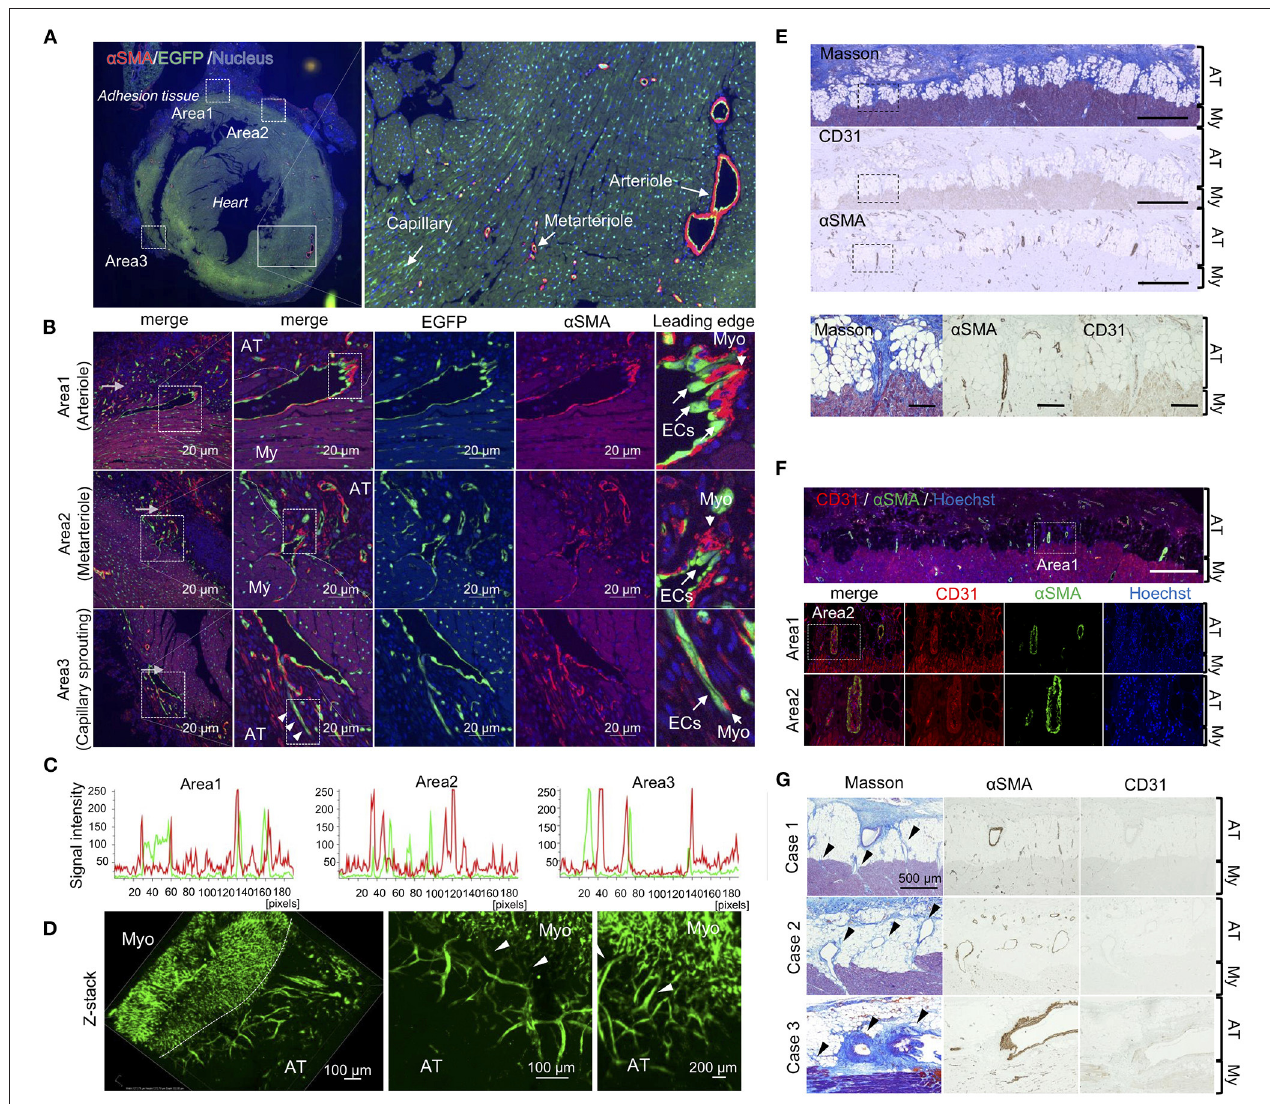
FIGURE 3 | Unique angiogenic sprouting from heart in mice and humans. (A) Left panel shows immunofluorescence of whole heart stained using anti- α SMA (red) and EGFP (green) antibodies. Nuclei were stained with Hoechst stain (blue). The right panel shows a magnified view of the quiescent area surrounded by solid lines in the left panel. (B) Magnified views of areas 1–3 in the left of (A) . The rightmost images indicate enlarged views of areas surrounded by broken lines in the second panel from the left. Arrowheads indicate sprouting vessels from the arteriole. Bar = 20 µ m. (C) Profiles of fluorescence signal intensities of α SMA ( red ) and EGFP ( green ) from areas 1–3 of the leftmost images in (B) . (D) Z-stacked images of heart tissue with adhesions in endothelial cell-specific EGFP-labeled mice. Heart tissue was excised and subsequently embedded into the type-I collagen gel, followed by obtaining z-stack three-dimensional images using A1 confocal microscopy. Arrowheads indicate vascular connective points between the heart and adhesions. My, myocardium; AT, adhesion tissue. (E) The upper panels show Masson’s trichome staining and immunohistochemical (IHC) results for α SMA and CD31 in the human heart (Scale bar = 1mm). The lower panels show magnified images of areas surrounded by broken lines in the upper panels (Scale bar = 200 µ m). (F) Immunofluorescence co-staining and analysis of CD31 and α SMA in human pericardial adhesion tissues. The upper panel shows the immunofluorescence co-stained specimen illustrating identical areas corresponding to those observed in the Masson’s trichrome-stained specimen image in (A) (Scale bar = 1mm). The lower panels show high-magnification images of area 1 in the upper panel. Scale bar = 200 µ m. (G) Histological evaluations (Masson’s trichrome and IHC for CD31 and α SMA) of three patients with pericardial adhesion. Arrowheads indicate sprouting vessels from the heart. (Scale bar = 500 µ m). My, myocardium; AT, adhesion